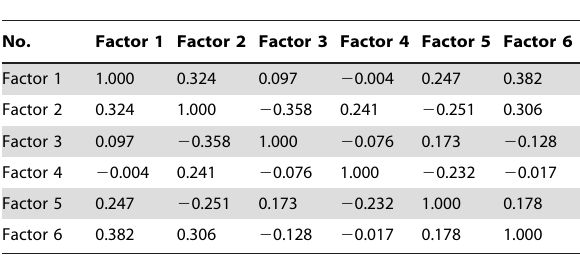
Table 2. The correlation coefficients among six